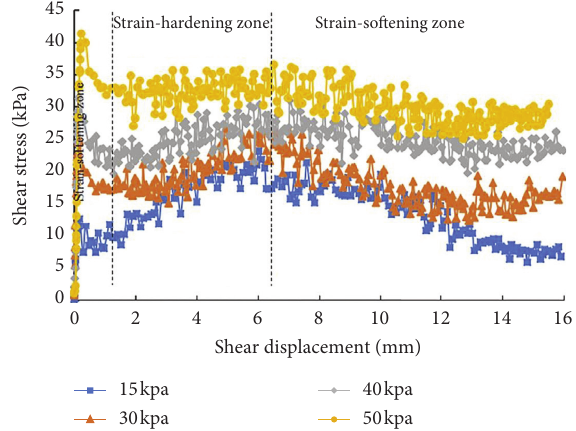
Figure 5: Shear stress and shear displacement curves of sand specimens.